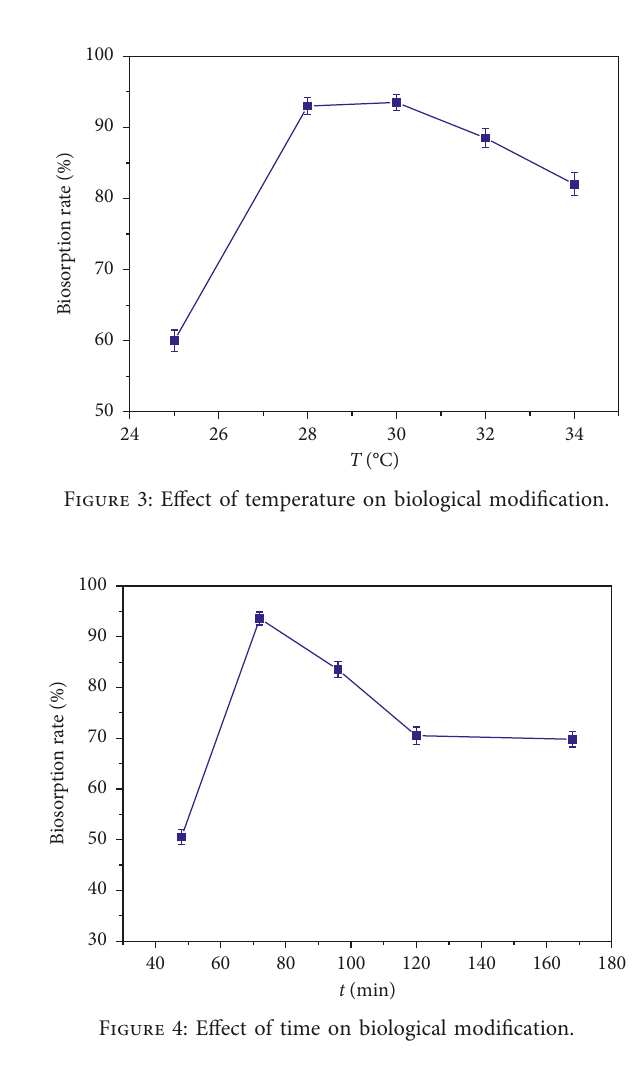
Figure 1: Effect of the solid-liquid ratio on biological modification.